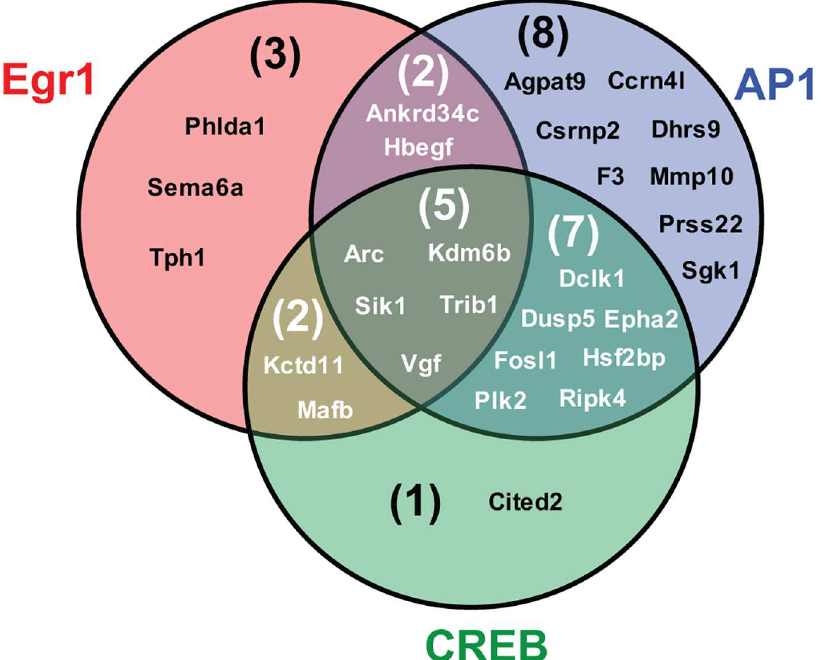
Fig 5. AP-1, CREB, and Egr1 cooperatively regulate 28 genes during their preferential expression in response to NGF and sustained ERK signaling. The Venn diagram summarizes genesbound by AP-1, CREB, and/or Egr1 duringtheir preferentially expression in responseto NGF and sustainedERK signaling, as detected by Mullenbrock et al. (2011) and the present